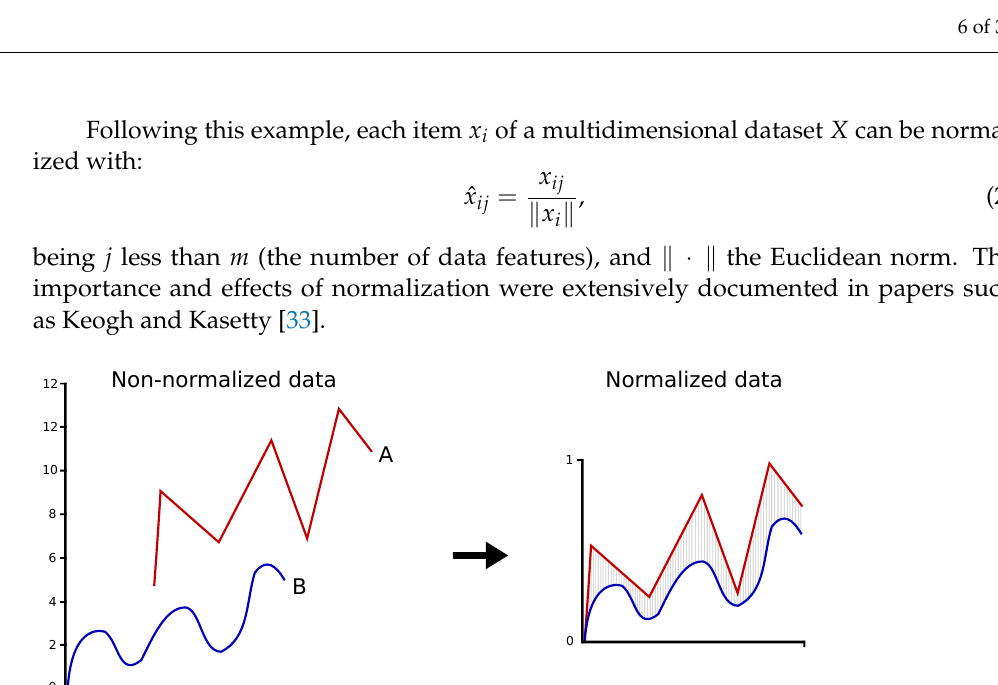
Figure 1. Vector normalization is applied to improve the (dis)similarity measure process. The shaded area between A and B sequences represents the real difference in magnitude between them. Source: elaborated by the